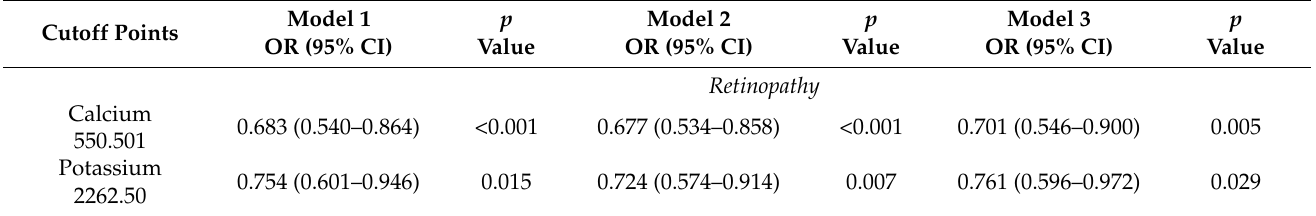
Table 3. Association between cutoff points of calcium and potassium, and the presence of diabetic